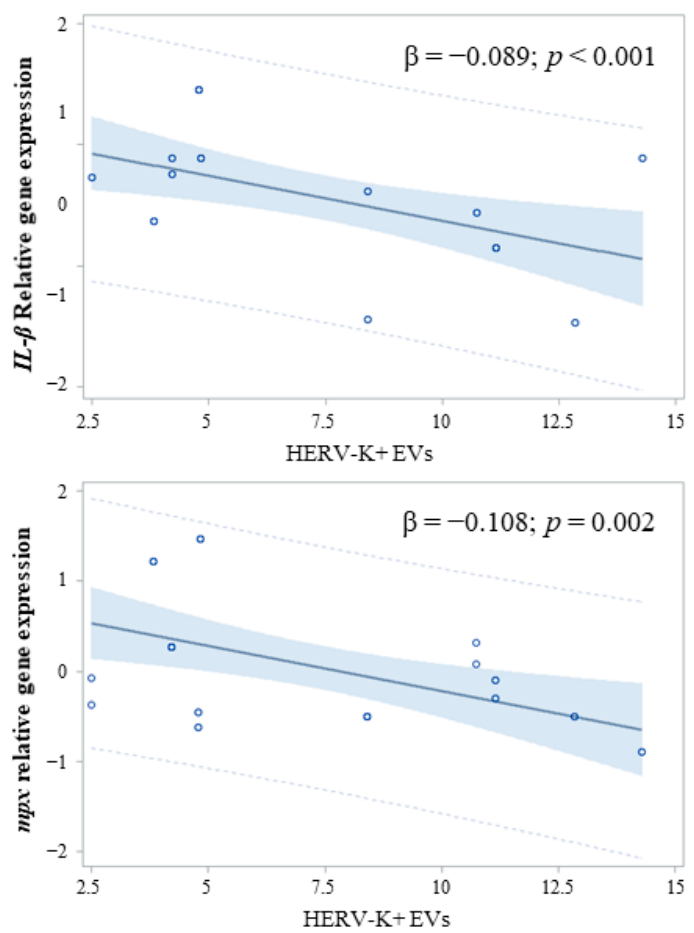
Figure 6. Association between HERV-K positive EVs and the expression of IL1- β and mpx .